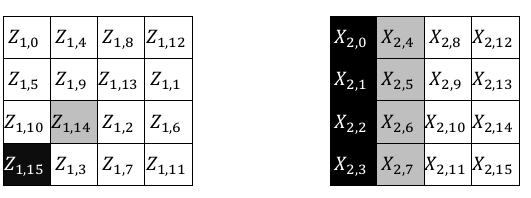
Figure 7: AES state after the first Shiftrows (left) and MixColumns (right) transformations.